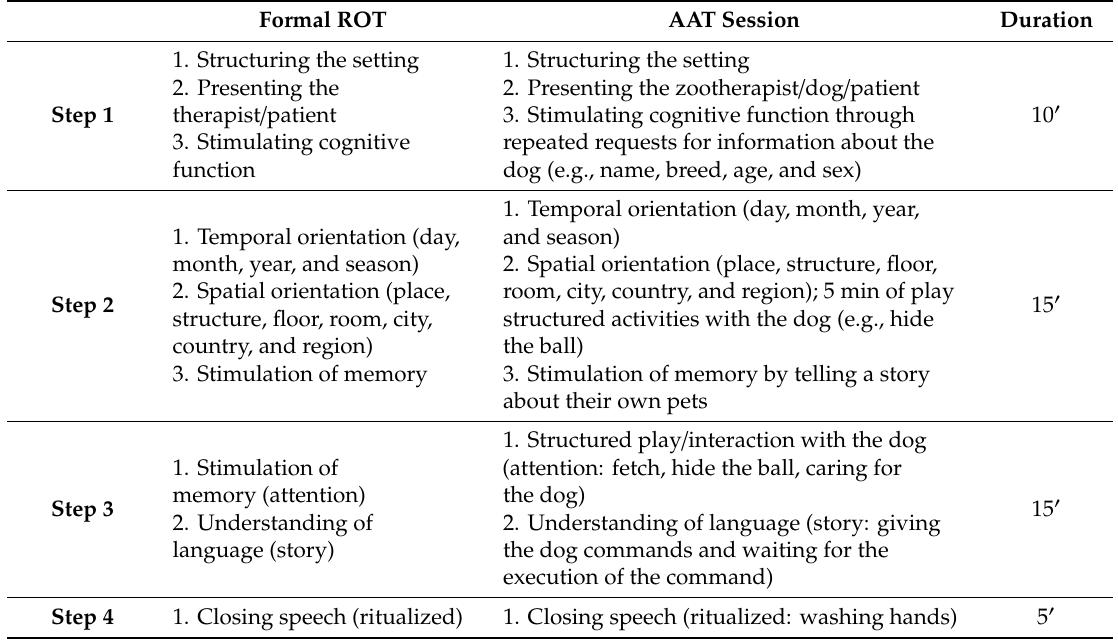
Table 1. Operational sequence and duration of each animal-assisted therapy (AAT) session with the dog addressed to the patients based on the formal reality orientation therapy (ROT) protocol by Menna et al.